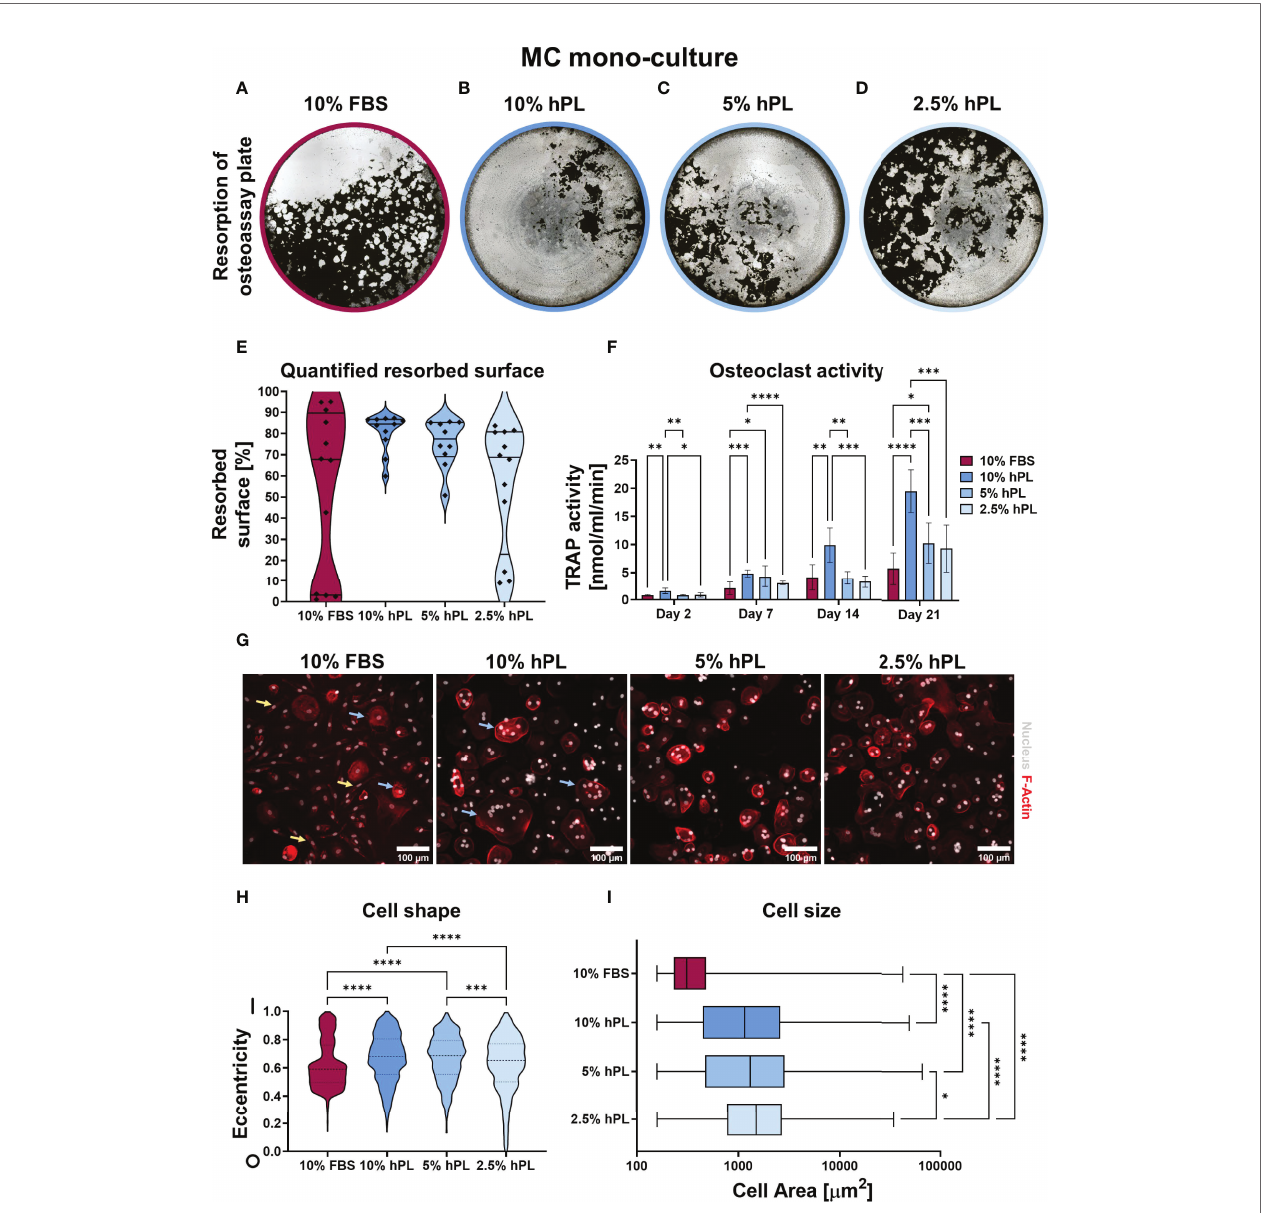
FIGURE 2 | (A – D) Von Kossa stained decellularized resorption plates of MC mono-cultures. (E) Quanti fi cation of resorbed area, p < 0.05 (Kruskal-Wallis). (F) TRAP activity quanti fi cation, p < 0.05 for culture time, culture condition and their interaction (two-way ANOVA and Turkey ’ s post hoc tests within each time